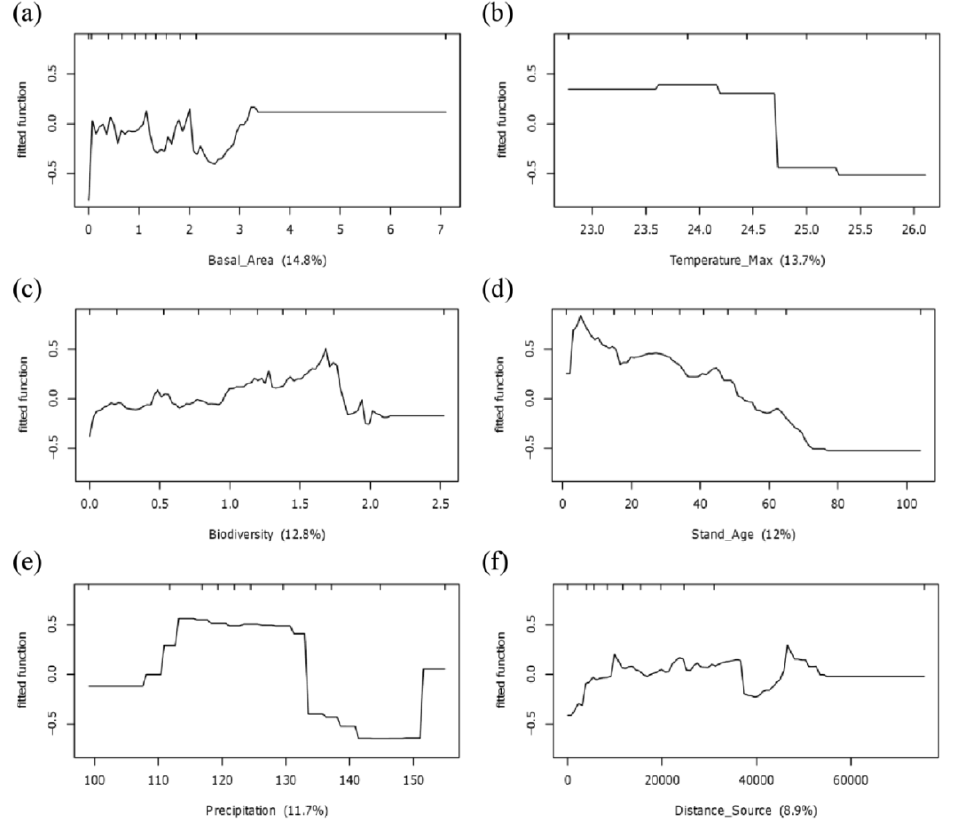
Figure 2. Cont. Figure 2.